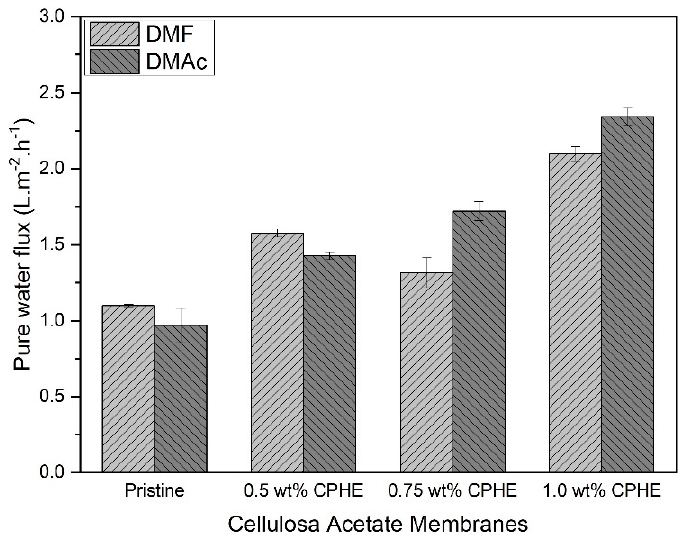
Figure 8. Pure water flux measured on each membrane.